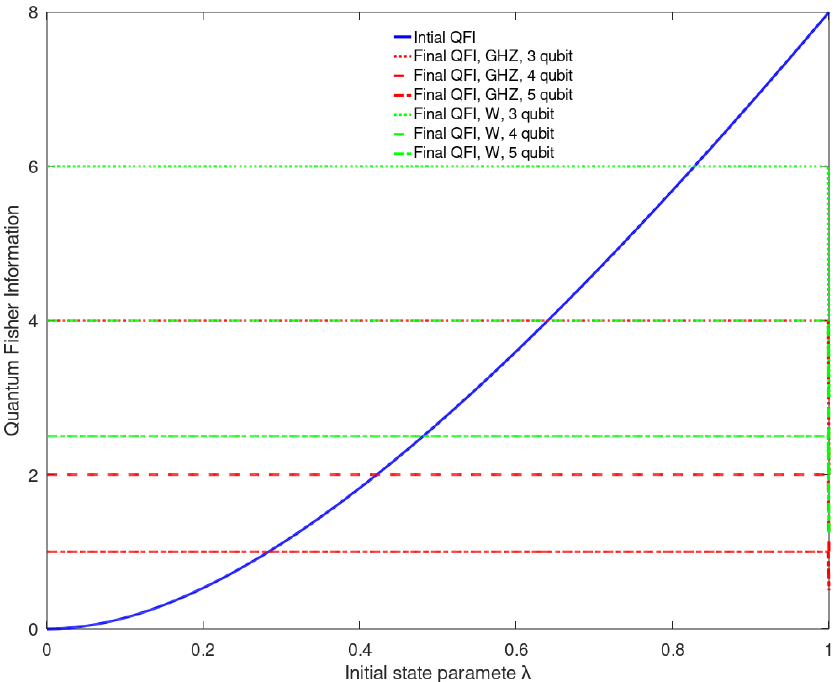
Figure 5. Average final QFI attained by Bob’s state with the W and GHZ states as a channel with an increasing number of qubits and the computational basis ( B (cid:48) solid blue line is the variation of QFI attained by Alice’s state. The green lines represent the QFI of Bob’s state with W state as a channel, and the red lines represent the QFI of Bob’s state with GHZ state as a